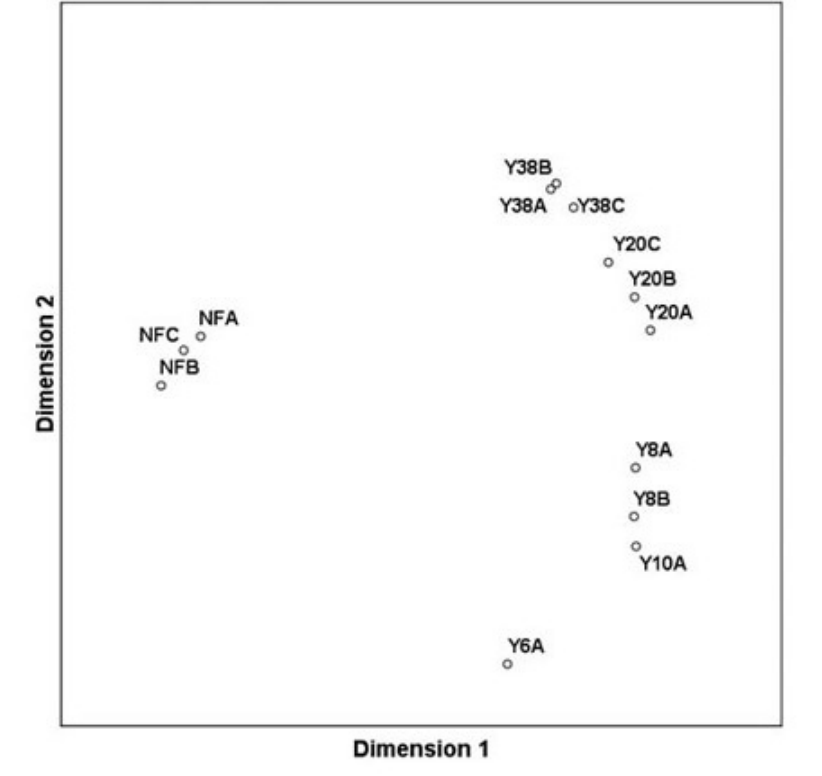
Figure 5. Multi-dimensional scaling of the species similarity matrix comparing plots from different stages of swidden-fallow succession. Plots with greater similar species composition are plotted more closely together in the figure. Numbers after ‘Y’ indicate number of years since cleared for cultivation. NF = natural forest. A, B, and C suffixes indicate replicate plots of same